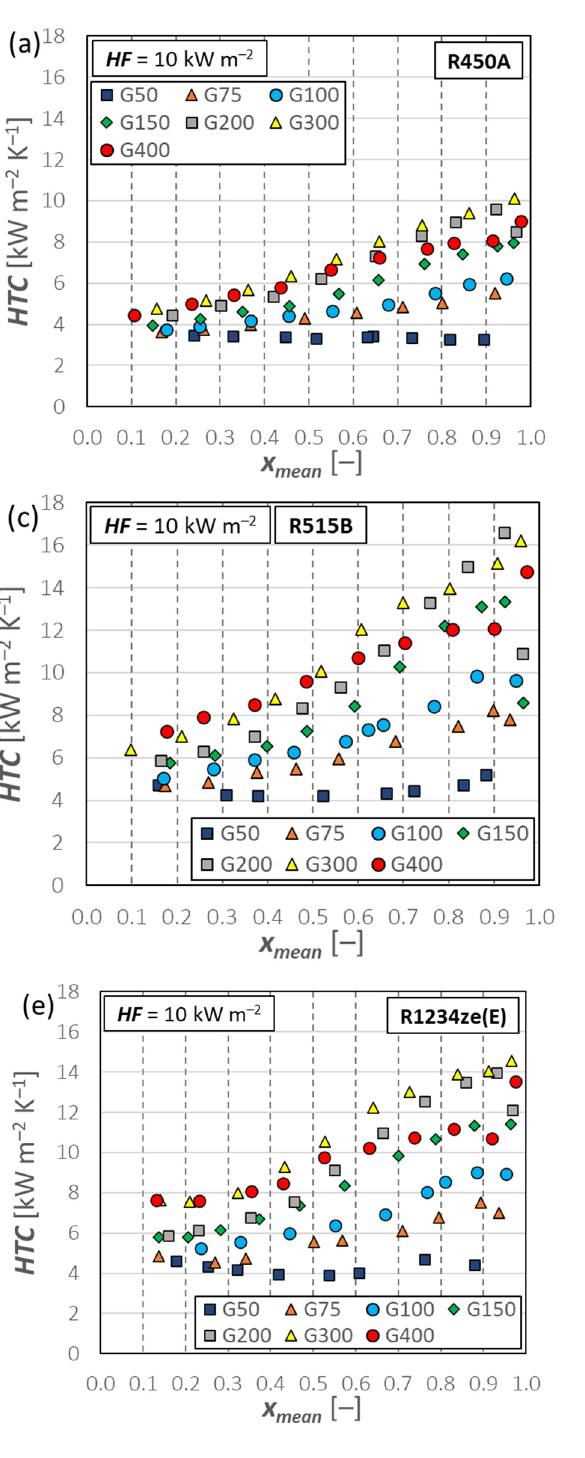
Figure 3. Heat transfer coefficient vs. mean vapor quality at t sat = 30 °C for R450A at HF = 10 kW m − 2 ( a ) and 50 kW m − 2 ( b ), for R515B at HF = 10 kW m − 2 ( c ) and 50 kW m − 2 ( d ), and for R1234ze(E) at HF = 10 kW m − 2 ( e ) and 50 kW m − 2 ( f ). G50 = 50 kg m − 2 s − 1 , G75 = 75 kg m − 2 s − 1 , G100 = 100 kg m − 2 s − 1 , G150 = 150 kg m − 2 s − 1 , G200 = 200 kg m − 2 s − 1 , G300 = 300 kg m − 2 s − 1 , and G400 = 400 kg m − 2 s − 1 . Figure 3c–f report the experimental heat transfer coefficients for R515B and R1234ze(E). The trend was similar at HF = 50 kW m − 2 , i.e., the heat transfer coefficients